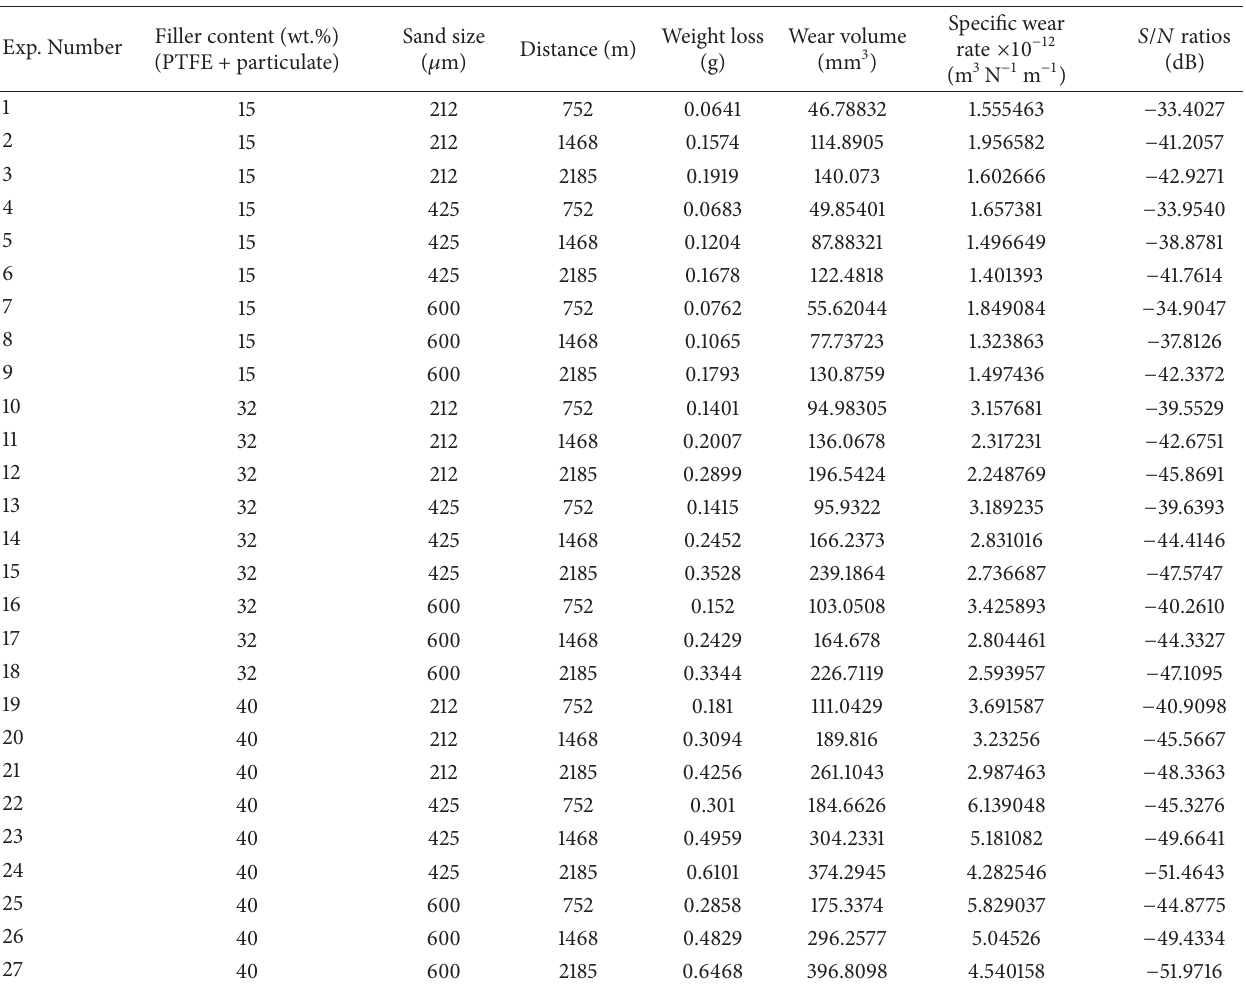
Table 7: Experimental design using 𝐿 27 orthogonal array.